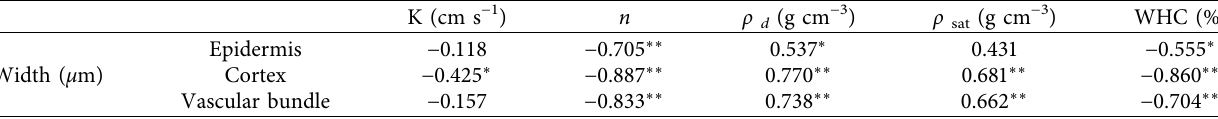
Table 5: Pearson correlation coefficients between soil hydromechanical characteristics and root tissue width at 5% risk of the